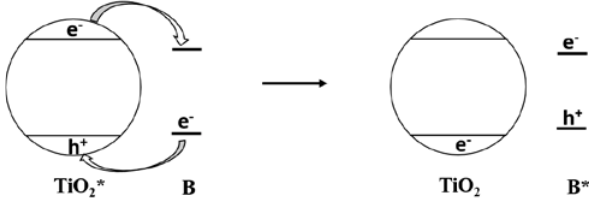
Figure 3. Dexter energy transfer